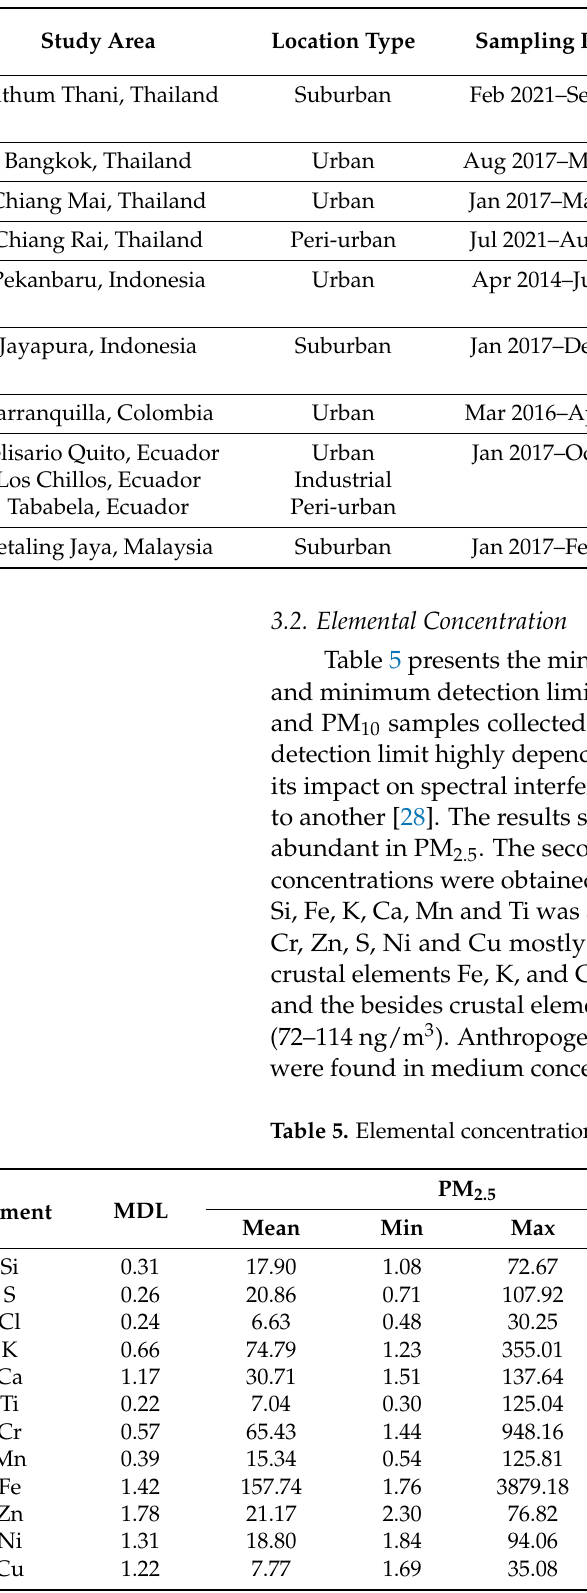
Table 4. PM 2.5 and PM 10 mass concentrations of this study and several tropical countries.